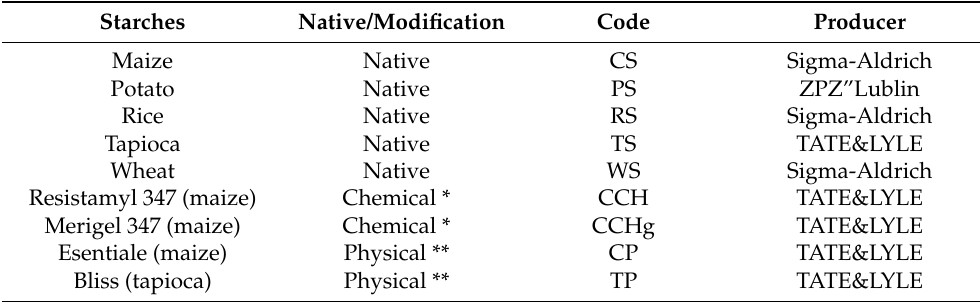
Table 6. Characteristics of the material used in the research.